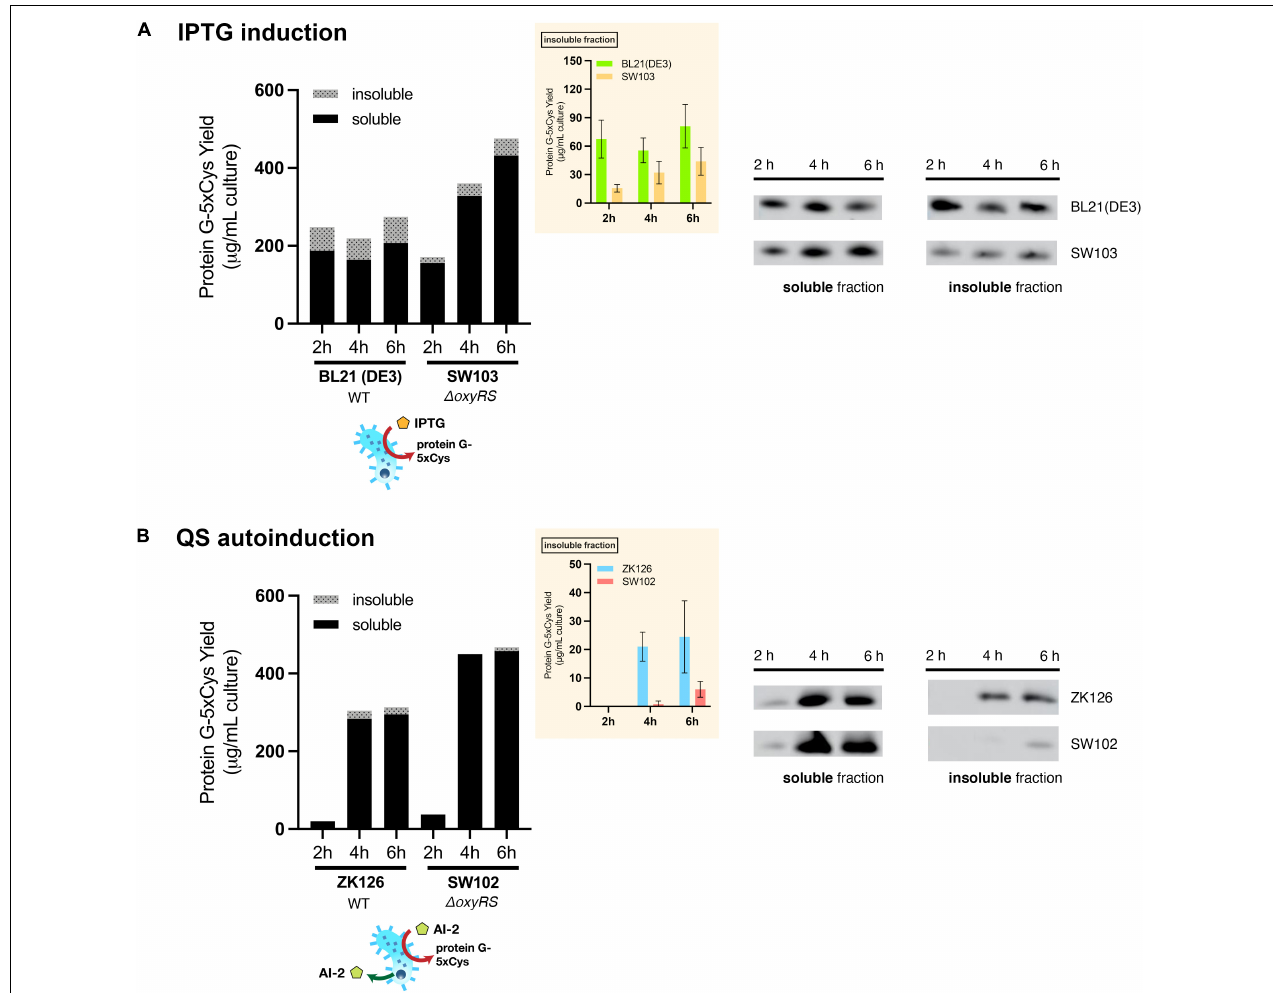
FIGURE 7 | Effect of oxyRS deletion to protein G-5xCys expression. (A) Total yield of protein G-5xCys ( µ g) per mL of IPTG-induced BL21 (DE3) and SW103 ( (cid:49) oxyRS ) culture analyzed by Western blotting. (B) Total yield of protein G-5xCys ( µ g) per mL of QS-autoinduced ZK126 and SW102 ( (cid:49) oxyRS ) culture analyzed by Western blotting. Black: soluble fraction; dotted: insoluble fraction. Plotted values are the average of biological replicates ( n = 3). Yields of protein G-5xCys in the insoluble fraction ( µ g/per mL culture) are also shown in the inset plot. Error bar represents the standard deviation between